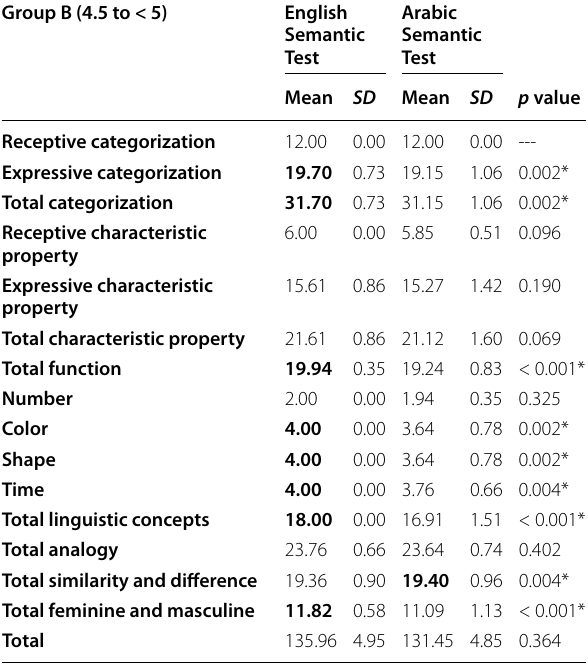
SD standard deviation, bold: higher value, *significant p value < 0.05